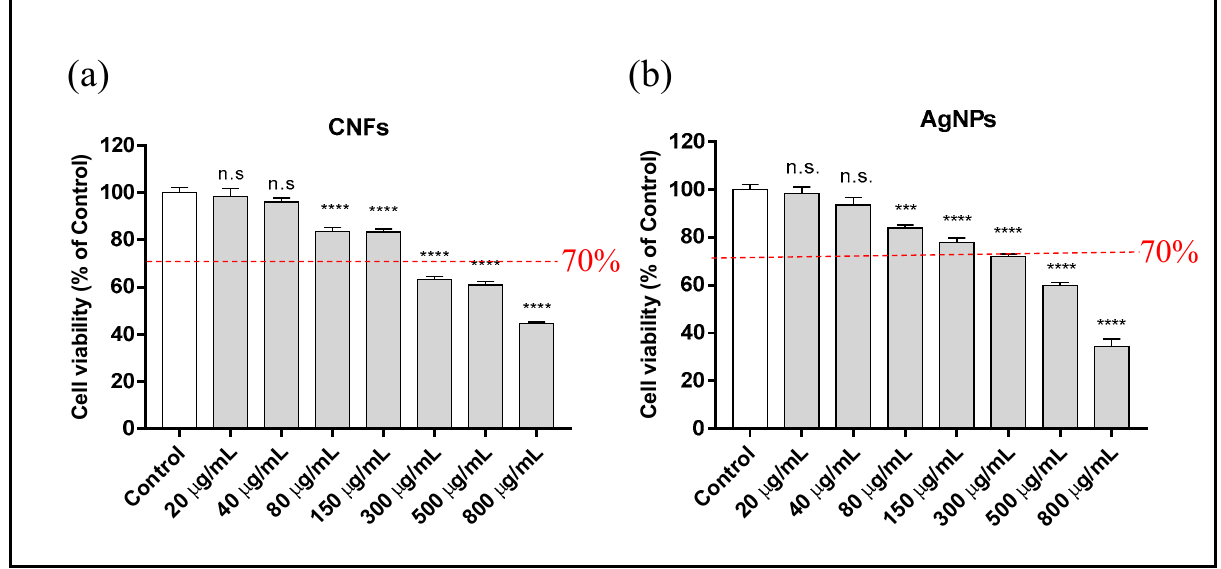
Figure 6. Cytotoxicity assay in human keratinocyte (HaCaT) cells, after 24 h exposure to AgNPs ( a ) or CNFs ( b ) at different concentrations ranging from 0 (control) to 800 µg/mL. Cytotoxicity was evaluated by the MTT assay. Results were represented as a % of the control group. Data are given as the mean ± standard deviation of six replicates. The ANOVA results of the different AgNP or CNF concentrations with respect to control are indicated in the plot. *** p < 0.001; **** p < 0.0001; n.s: not significant. The limit of cell viability (70%) for the compounds to be considered non-cytotoxic is indicated.